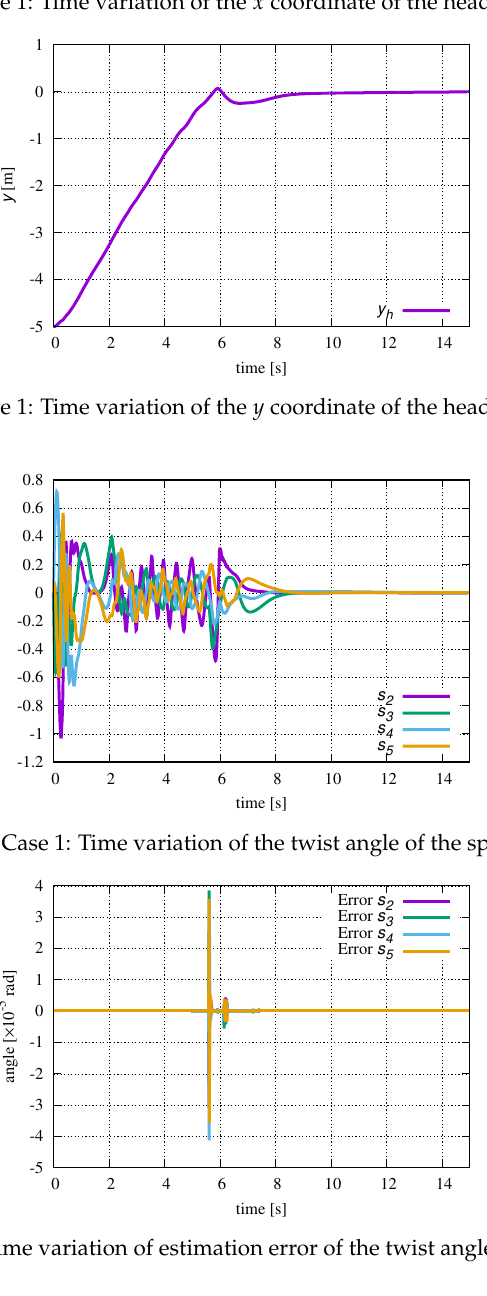
Figure 5. Case 1: Time variation of the x coordinate of the head position.